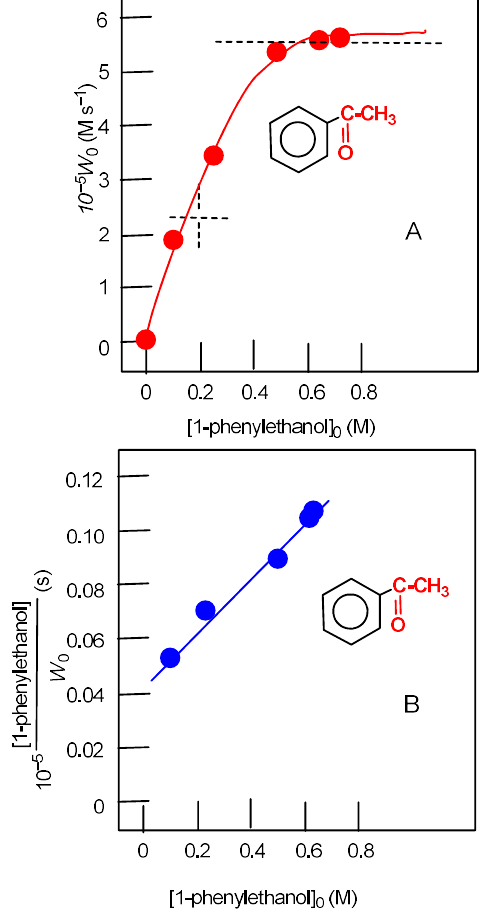
Figure 9. The dependence of the initial oxidation rate W 0 on the initial concentration of 1-phenylethanol in its oxidation into acetophenone with tert -butyl hydroperoxide (1.5 M) catalyzed by complex 1 (5 × 10 −4 M), 50 °C. Concentrations of products were measured by GC only after the reduction of the reaction sample with solid PPh 3 in order to quench the oxidation process. Linearization of the curve, as shown in Graph A , is presented in Graph B